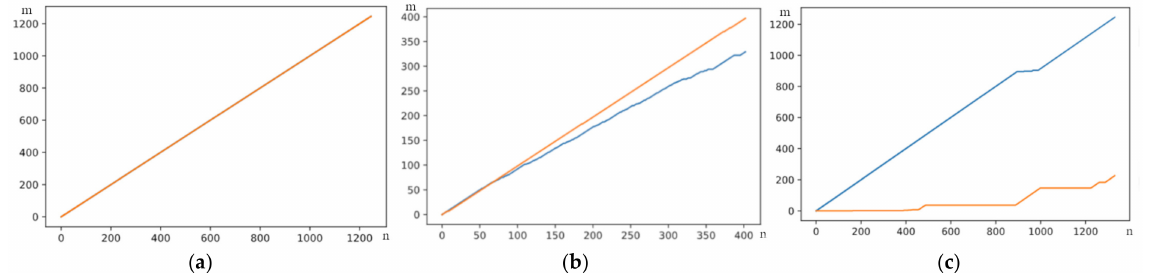
Figure 8. Comparator DTW. ( a ) Word Path of Pattern. ( b ) Comparison of a word (blue) sample with its own pattern (orange). ( c ) Comparison of a word (orange) other than the pattern (blue).